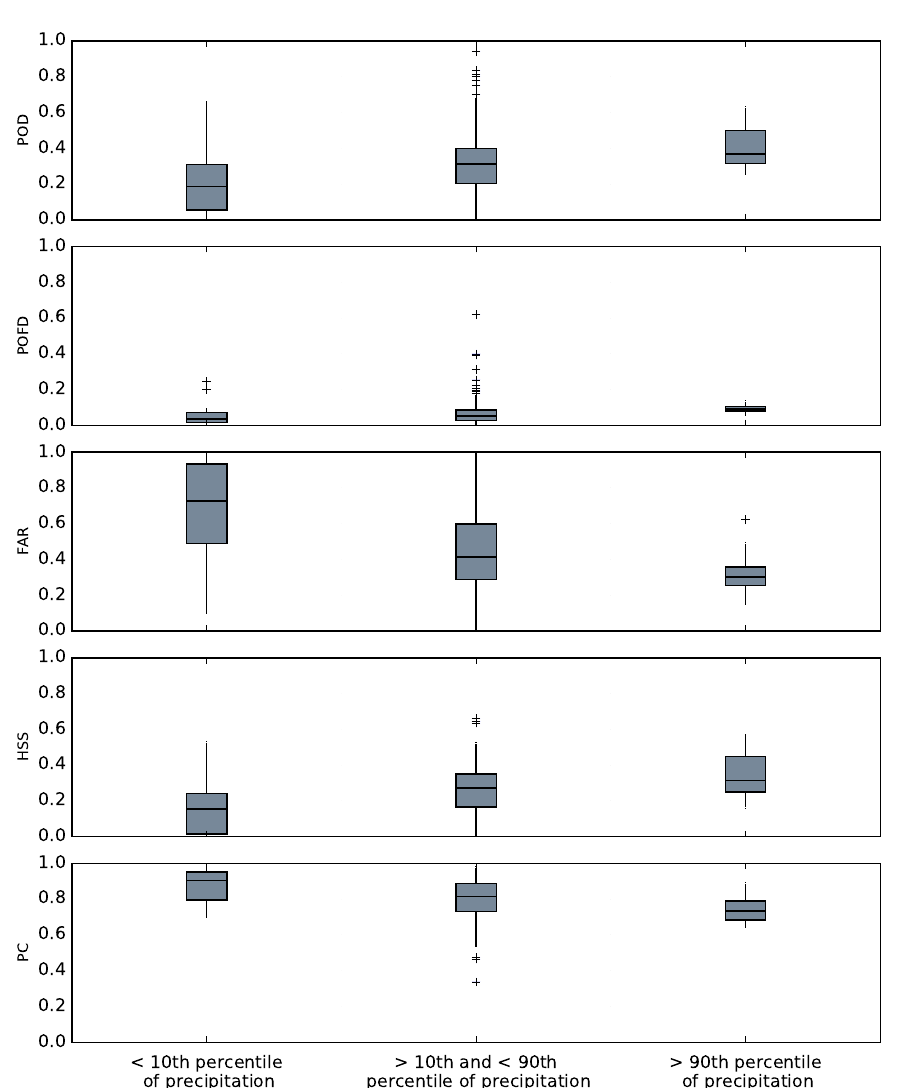
Figure 9. Performance of the precipitation area delineation using IR only precipitation for July 2017 as boxplots for low, medium and high precipitation rates according to percentiles. The boxes display the 25th, 50th and 75th percentiles. Whiskers indicate extreme data up to 1.5 times of the interquartile range. Outliers are marked as crosses. The width of the boxes is relative to the available number of validation